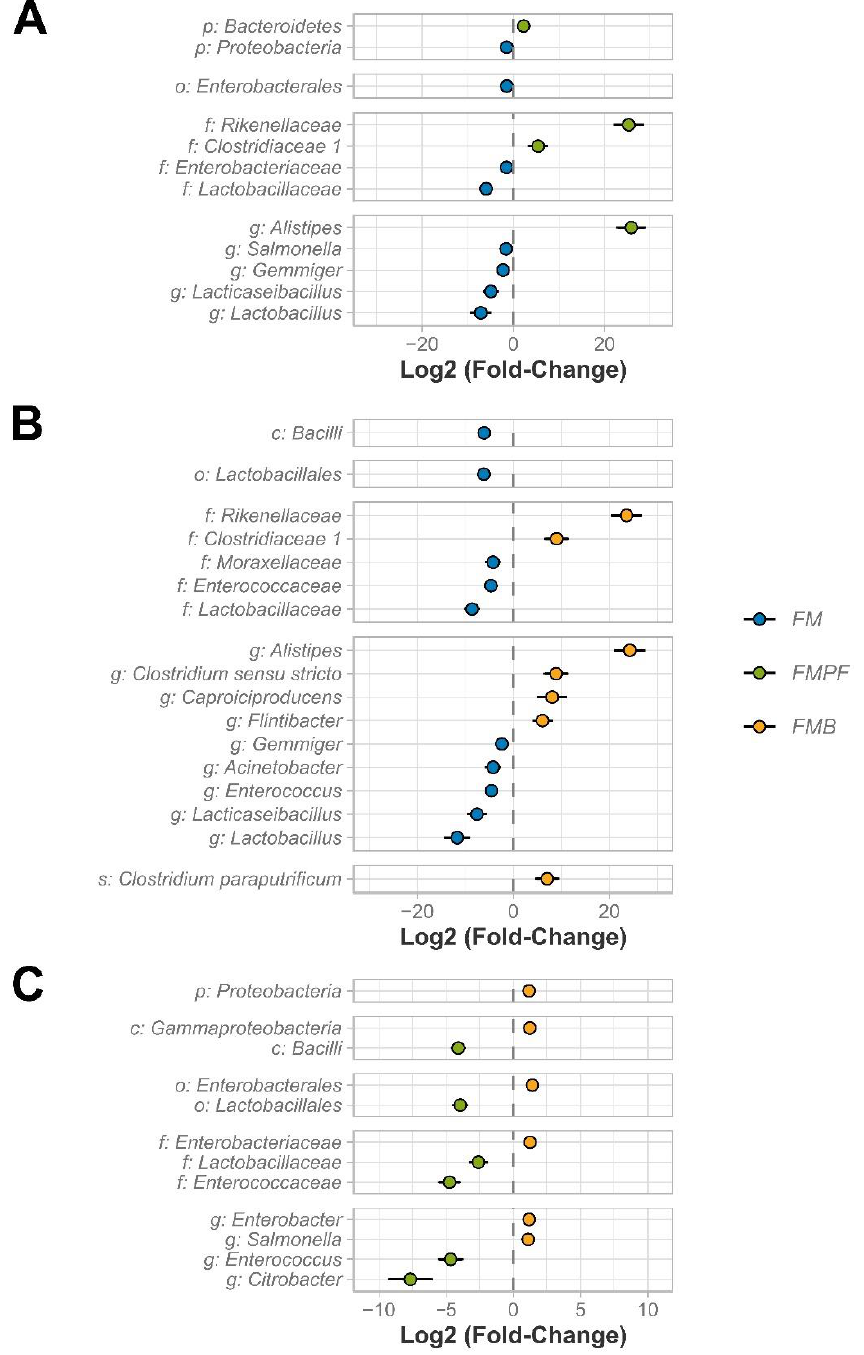
Figure 5. Differential abundant (DA) taxa among fermented milk treatments. The dot plots represent the mean intensity of the difference (fold-change) complemented by the standard error. The taxa are preceded by letters that represent the taxonomic level, namely, phylum (p), class (c), order (o), family (f), genus (g) and species (s). Comparison between FMC vs. FMPF ( A ), FMC vs. FMB ( B ) and FMPF vs. FMB ( C